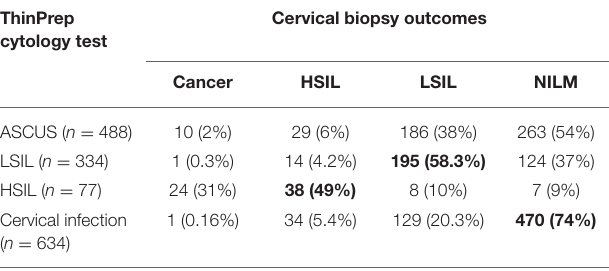
TABLE 2 | The concordance of the results between ThinPrep cytology test and cervical biopsy in women diagnosed with cervical infection, ASCUS, LISL and HSIL ( n = 1,533).